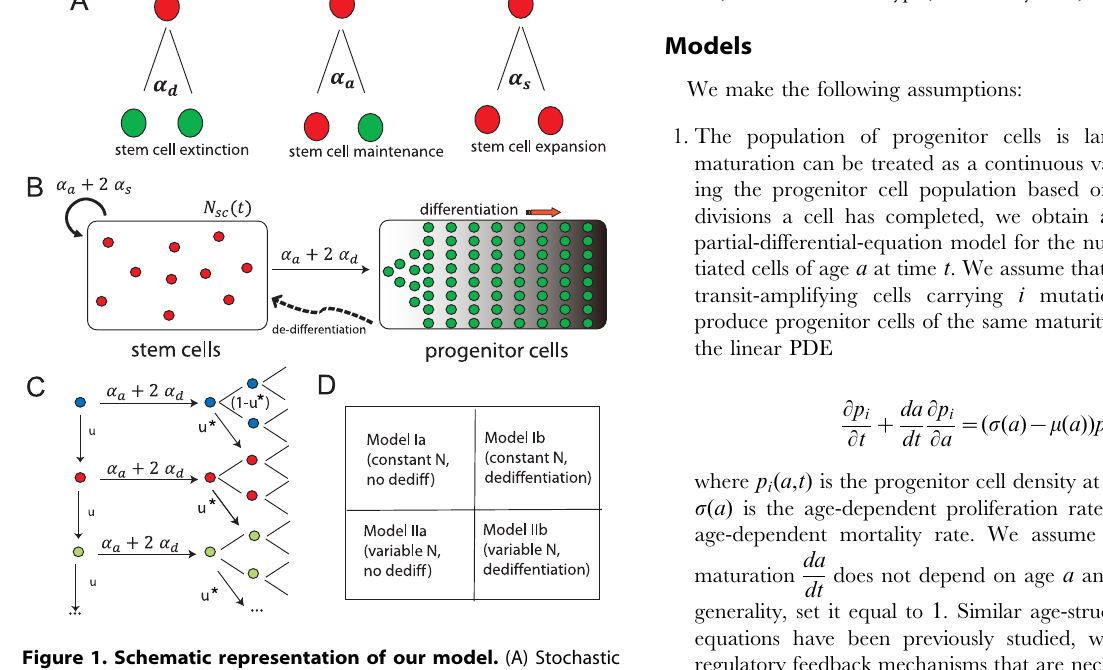
Figure 1. Schematic representation of our model. (A) Stochastic model for stem cell division. A stem cell can produce zero, one, or two stem cells with probabilities a D , a A , and a S , respectively. The mean number of offspring is given by m ~ a A z 2 a S . (B) Stem cells serve as an input to the proliferating progenitor population, and the progenitor population feeds back to the stem cell pool via dedifferentiation. (C) Mutation occurs with rate u during division and can affect cells both in the stem cell and progenitor pools. Blue circles represent wild-type cells, red circles cells with one mutation, and green circles cells with two mutations. (D) The sequence of models explored in this paper.